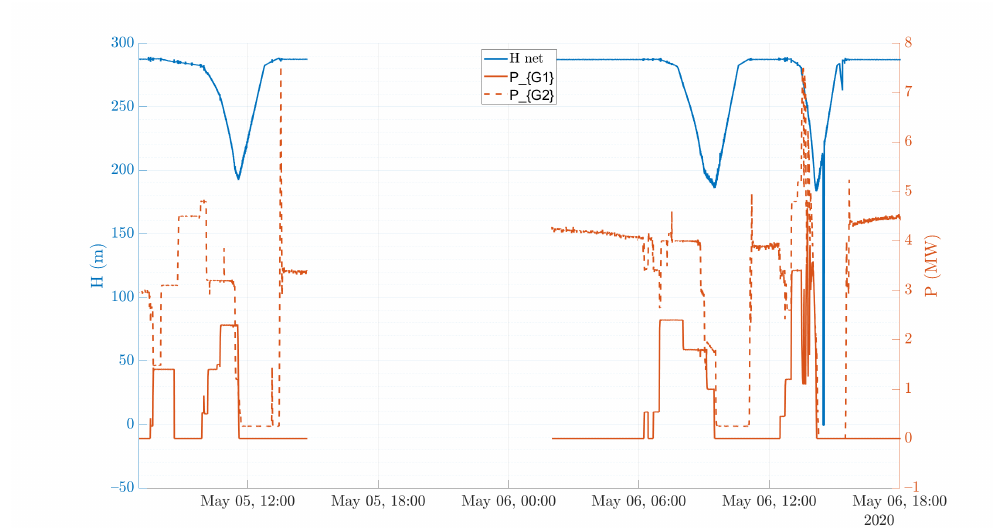
Figure 13. Time history of the head and the power of the two Pelton groups during the two days of tests of the second campaign. The sharp head decrease after the third peak of production is due to the closure of the vane at the bottom of the penstock at the end of the test.